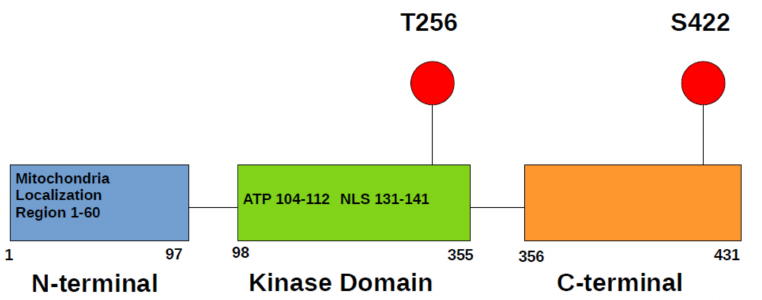
Figure 1. SGK1 domain structure. There is region necessary for mitochondrial localization in N- terminus and nuclear localization signal (NLS) in kinase domain. Kinase domain also contains ATP binding pocket. Most important activating phosphorylation sites are located in kinase domain and C-terminus.